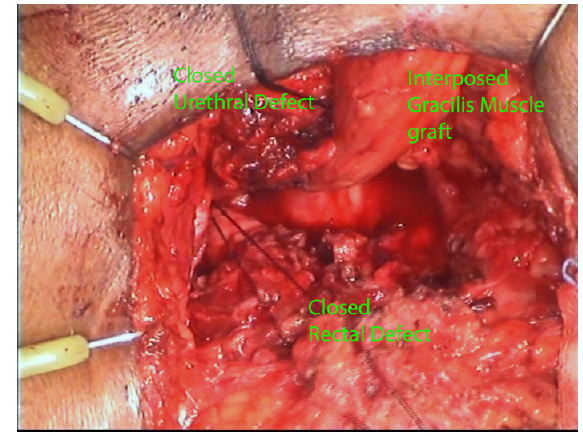
Figure 7. Gracilis muscle flap interposed and fixed between rectal and urethal repair.